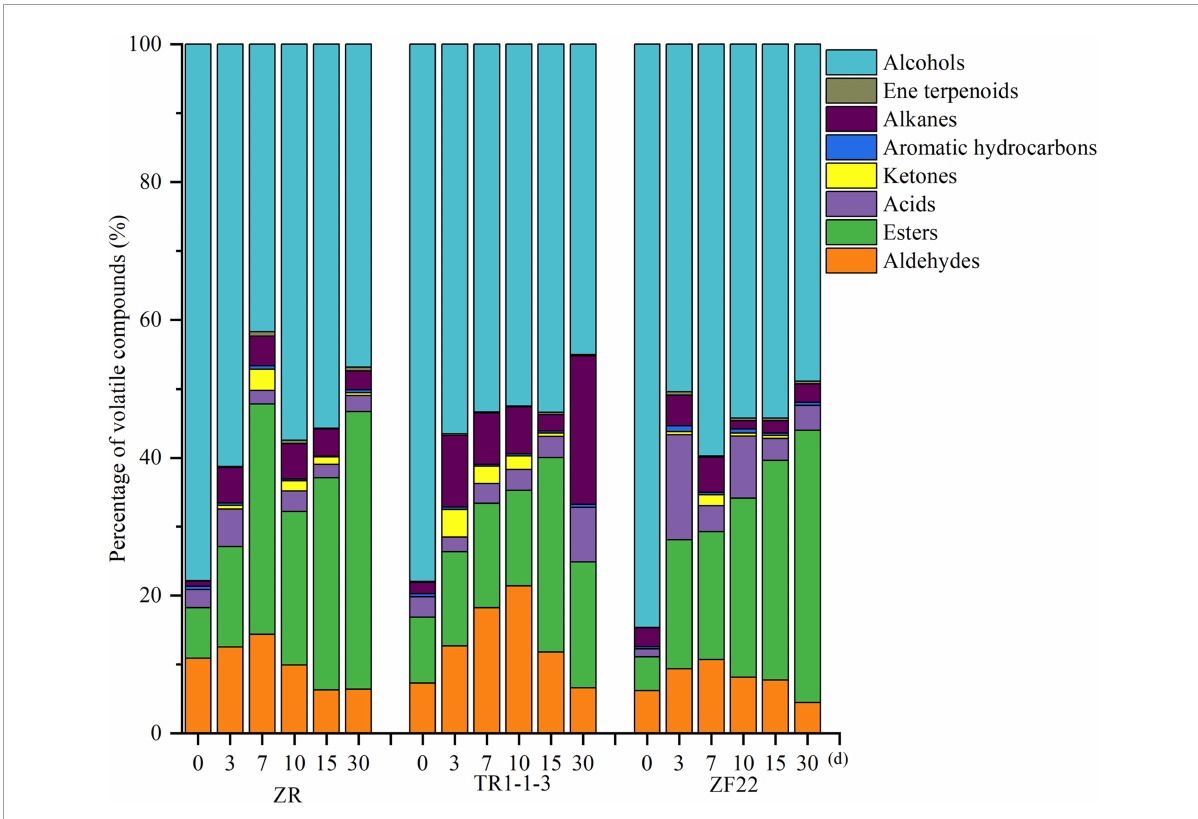
FIGURE2 Percentage of volatile substances in fermented sausages. A total of 0, 3, 7, 15, and 30 indicate the processing time of fermented